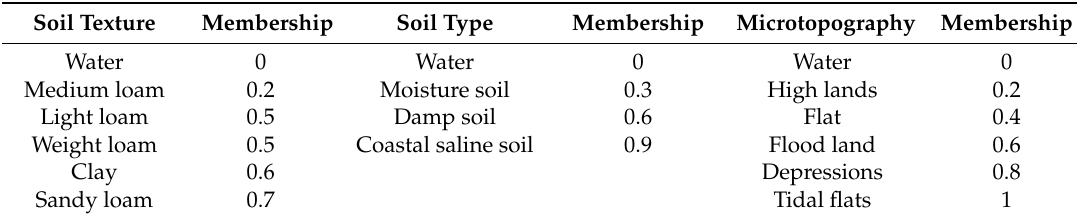
Table 4. Membership values of different soil characteristic and microtopography.